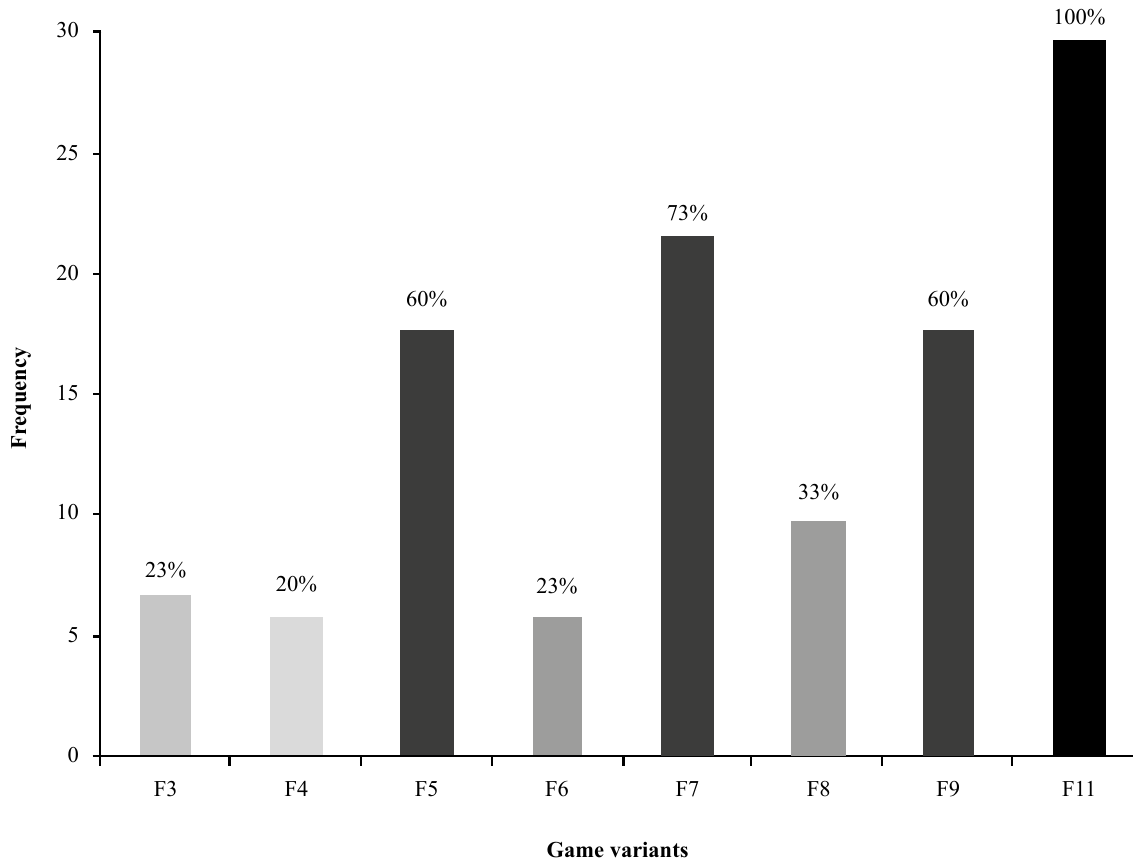
Figure 2: Overall frequency (%) of game variants used in UEFA member countries. Note: F3 = 3-a-side variant; F4 = 4-a-side variant; (......); F11 = 11-a-side variant